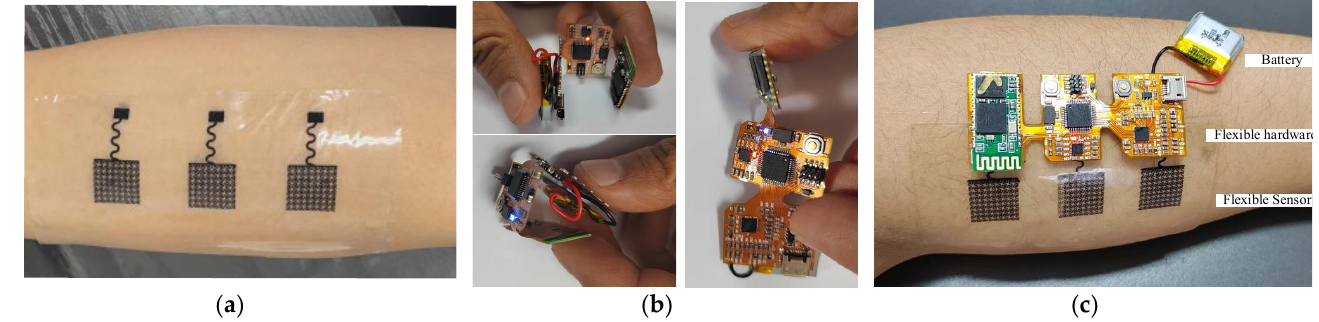
Figure 14. ( a ) The flexible sEMG sensor based on PMDS has good adhesion. ( b ) The hardware has